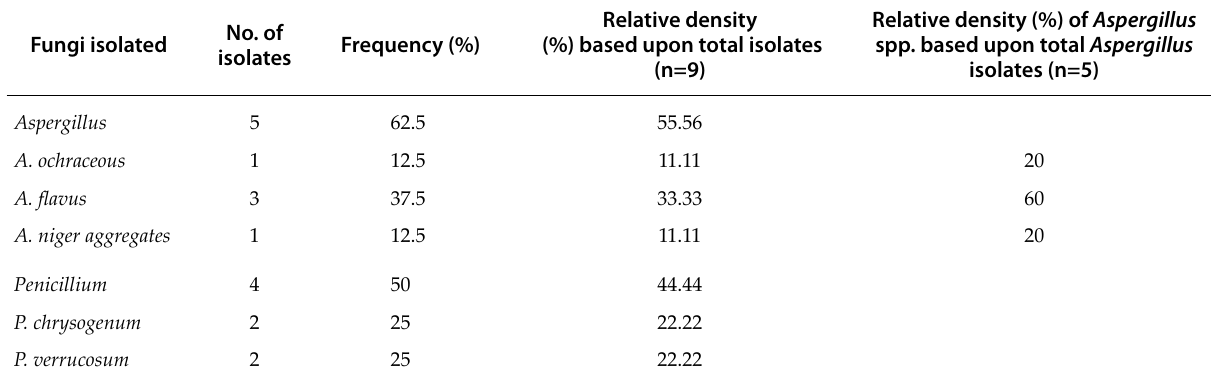
Table 2. Isolation frequency and relative density of different fungal genera and species isolated from maizegluten meal samples (n=8).